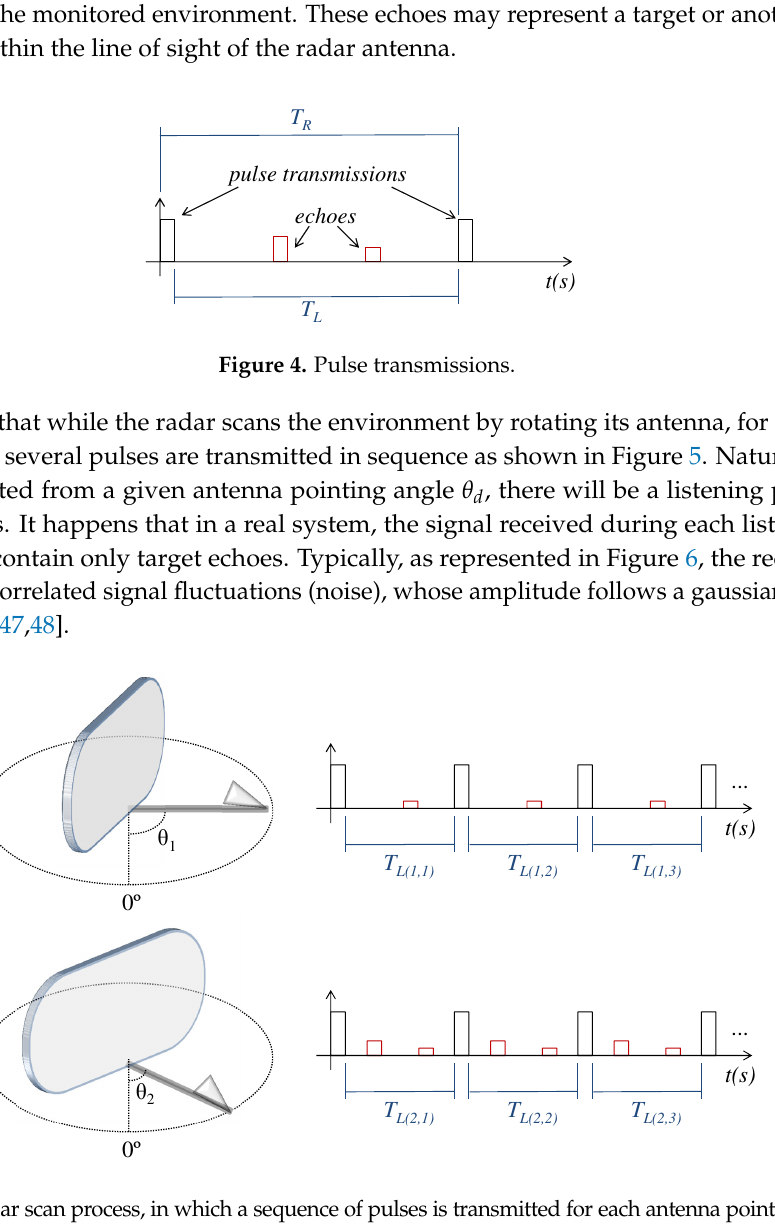
Figure 5. Radar scan process, in which a sequence of pulses is transmitted for each antenna pointing